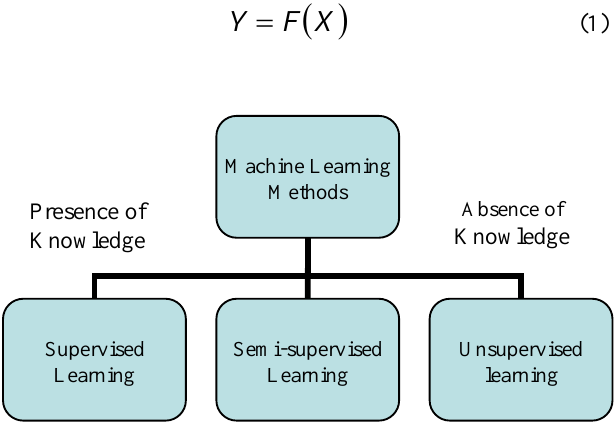
Figure 2. Machine learning